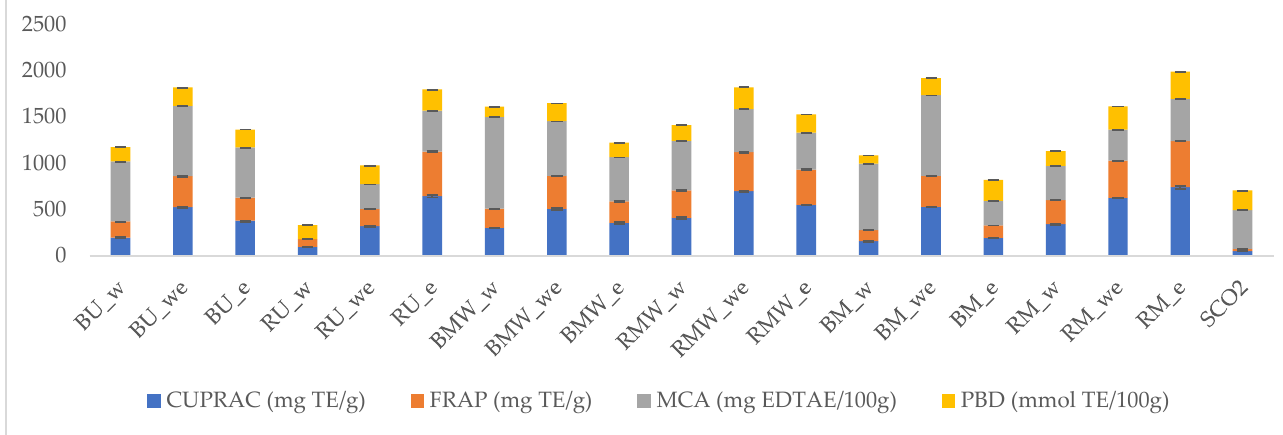
Figure 5. Reducing power (CUPRAC and FRAP), metal chelating (MCA) and total antioxidant capacity (by phosphomolybdenum assay (PBD)) of the tested extracts. Data are expressed as Trolox equivalent (TE) and EDTA equivalents (EDTA E).